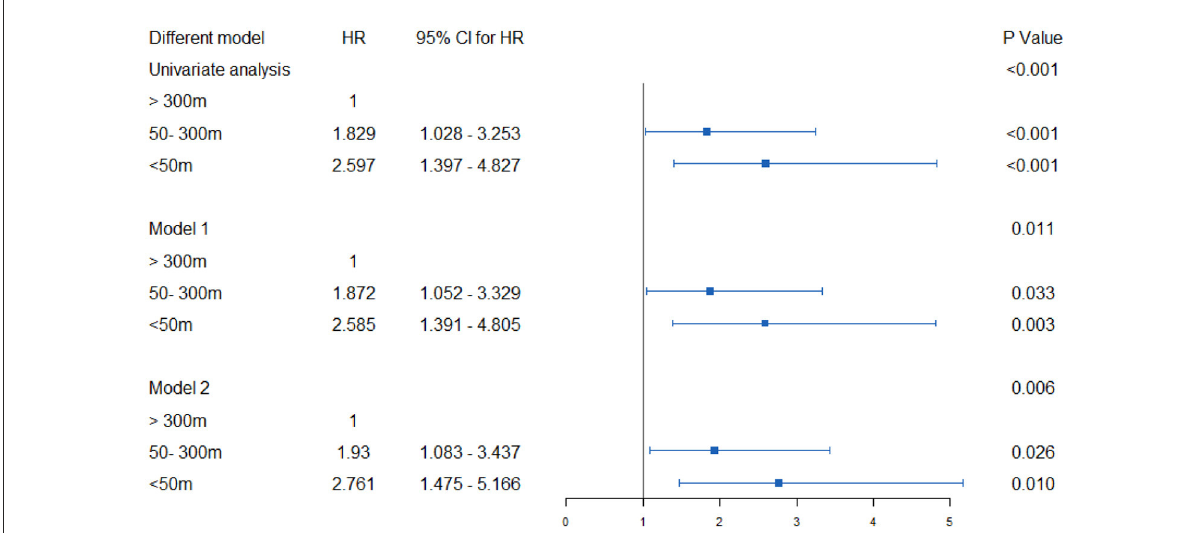
FIGURE4 Hazard ratios and 95% CI for associations between residential proximity to major roadways in 2007 and the risk of incident osteoporotic fracture in Beijing during the follow-up period 2007–17. Indirect adjustment for smoking, body-mass index (BMI), physical activity, and attained education. Data of smoking, BMI, physical activity, and educational attainment were obtained from BONE study, and who were 55 to 81 years old at the time of the surveys ( n = 529). Major traffic roads include primary urban roads and arterial roads, as defined by Beijing Government Road Network Data Standards. Cox proportional hazards model with age as time axis, adjusted for history of diabetes, hypertension, coronary heart disease, stroke, household income, education, etc. Using the natural logarithm of distance, set the distance as a continuous variable. The hazard ratio represents the distance that increases every intertertrtile-range. model 1: Age, BMI, Menopause, education degree, monthly household income, PASE level; Model 2: ge, BMI, Menopause, education degree, monthly household income, PASE level, hypertension, hyperlipidemia, diabetes, coronary heart disease, stroke, parental history of hip fracture, glucocorticoid rheumatoid arthritis, smoking,